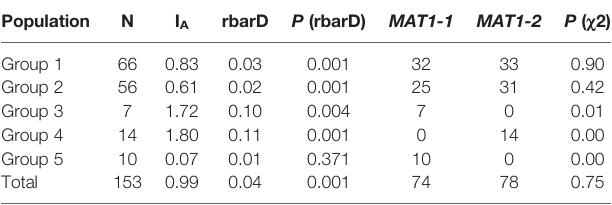
TABLE 3 | I A, rbarD and mating type assignments of the Australian P. nodorum groups.